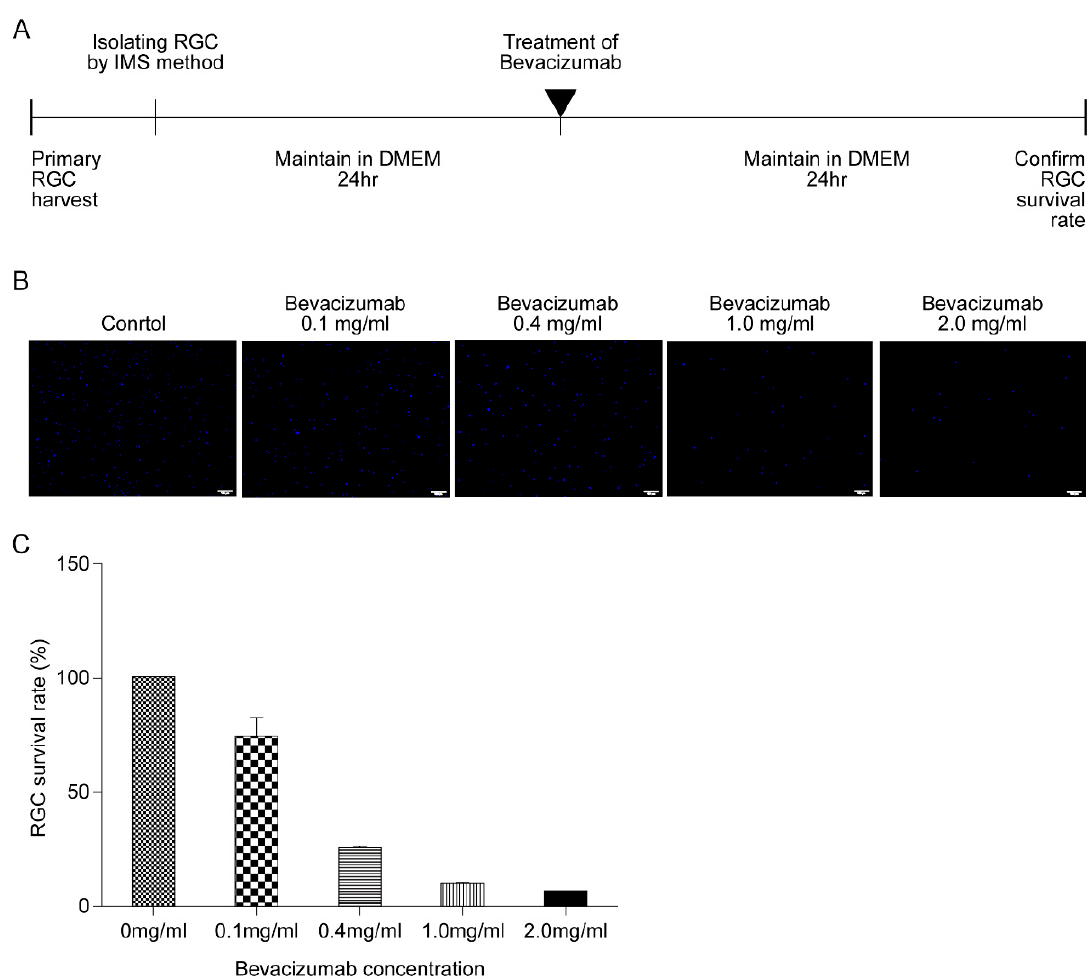
Figure 4. Retinal ganglion cell (RGC) survival rate according to antivascular endothelial growth factor (VEGF) antibody concentration. ( A ) After treatment with different concentrations of bevacizumab (0.1, 0.4, 1.0, and 2.0 mg/mL), RGCs were maintained in a defined medium for 24 h, and cell survival rates were compared. ( B , C ) Representative images and number of RGCs after bevacizumab treatment (0.1, 0.4, 1.0, and 2.0 mg/mL). Scale bar, 100 µ m.